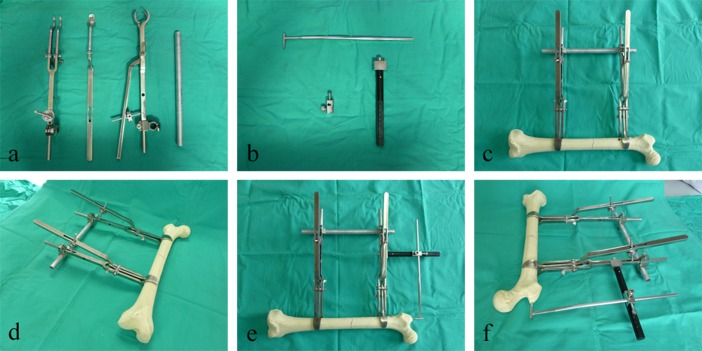
Picture of the instrument developed.(a) bone forceps, bar, and connectors of the fracture reduction device; (b) column, calibrated bar, and slider of the guidewire-aiming device; (c, d) assembled fracture reduction device on a model of the femur; (e, f) assembled fracture reduction device and guidewire-aiming device on a model of the femur.